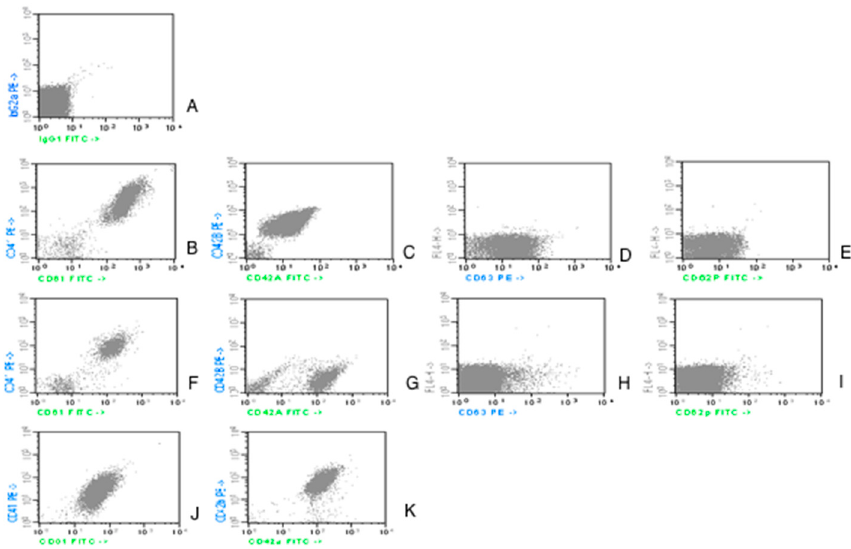
Figure 1. Dot-plot acquisition histograms representing expression of CD61 and CD41 on platelets in AML patients study group.